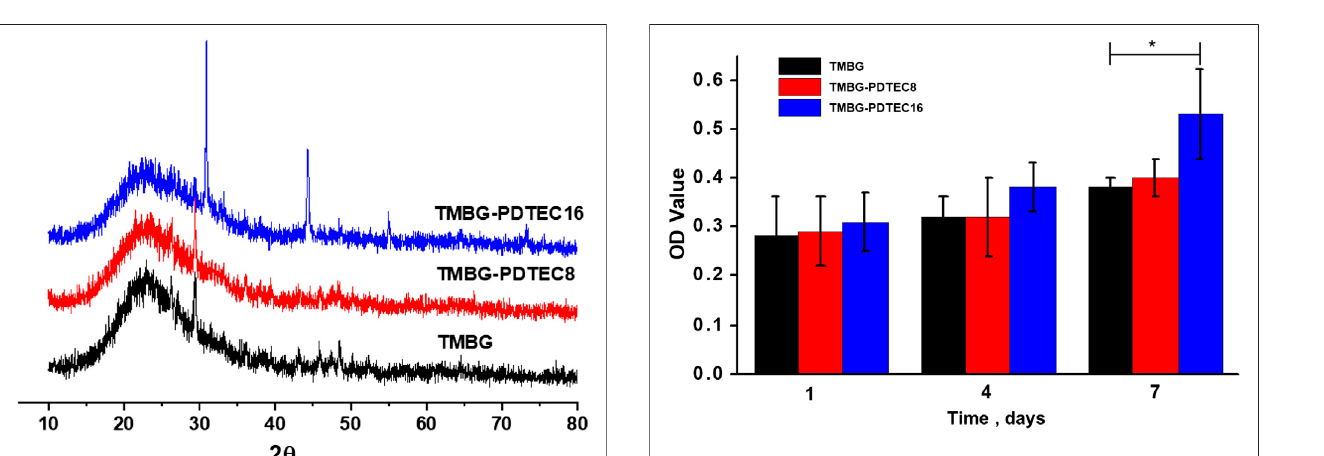
FIGURE 7 | Cell proliferation of rat bone marrow stromal cells (rBMSCs) incubated with TMBG, TMBG-PDTEC8, and TMBG-PDTEC16 scaffolds as a function of the culture period (1, 4, and 7 days). (* p < 0.05 compared to